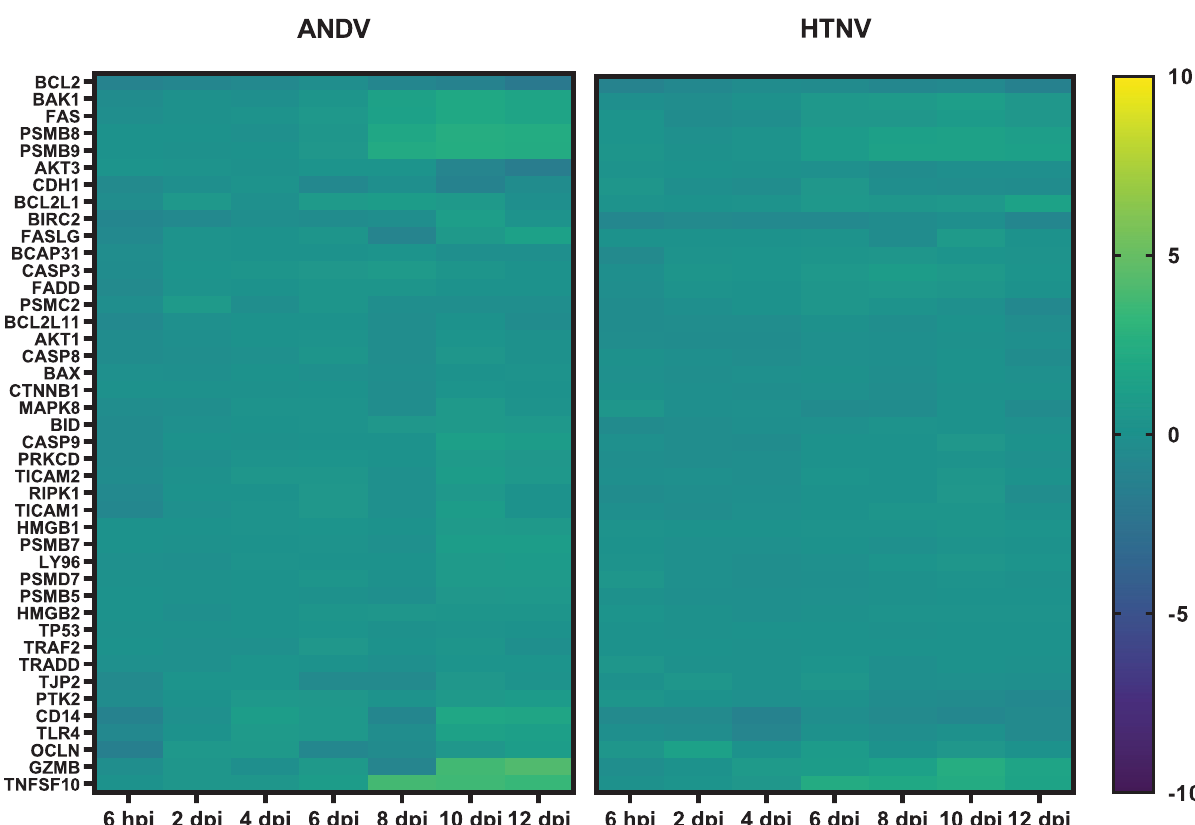
Fig 9. Apoptosis Pathway Expression in Hantavirus Infected Hamsters. Genes associated with apoptosis pathway expression are displayed as a heat map with hierarchical clustering and intensity of the colors corresponding to the magnitude of fold change over the baseline.